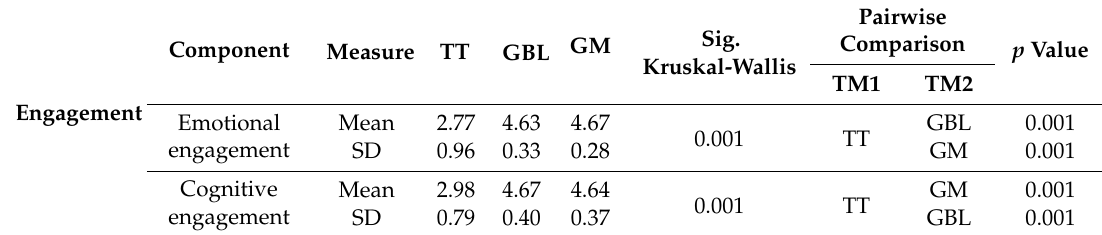
Table 6. Mean (SD) of teaching methods for the Engagement